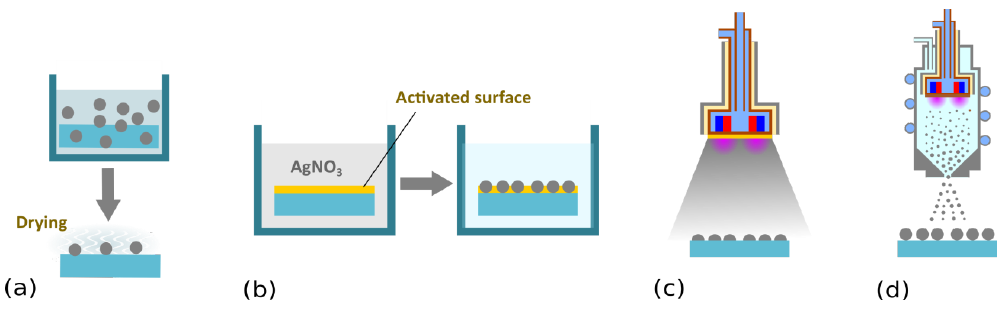
Figure 2. Schematic representation of possible strategies for coating substrates with Ag NPs. ( a ) Immersion into a colloidal solution of Ag NPs, followed by drying (e.g., [63,67,75]). ( b ) Salt reduction. Substrates are commonly exposed to silver nitrate solution. AgNO 3 is, in the second step, reduced by an appropriate reducing agent (e.g., sodium citrate, sodium borohydride, or even H 2 plasma) [76–79]. ( c ) Direct current (DC) magnetron sputtering. In this low-pressure vacuum-based plasma deposition technique, a silver target mounted onto a DC magnetron is subjected to a flux of highly energetic ions produced in the plasma bulk. This leads to the emission of silver atoms that condense on a substrate located in the deposition chamber. Depending on the deposition conditions (magnetron current, pressure, deposition time, etc.) various silver nanostructures are formed that range from individual separated nanoislands to interconnected Ag networks (e.g., [59,80–87]. ( d ) Deposition of Ag NPs by means of a gas aggregation source equipped with a silver target. Gas aggregation sources based on magnetron sputtering were introduced by Haberland et al. [88] and since then were successfully applied for the fabrication of different kinds of nanoparticles (for more information, readers should refer to the instance to monography [89] or recent review articles [90–93]). In contrast to sputter deposition, silver nanoparticles are already formed in a volume of the aggregation chamber as a result of gas-phase nucleation of sputtered atoms, which is followed by the coagulation or coalescence of growing nanoparticles. As shown by our group, the fact that NPs are formed in the gas-phase means their properties are not dependent on the substrate material, which makes it possible to independently control the size and number of deposited NPs [94,95].